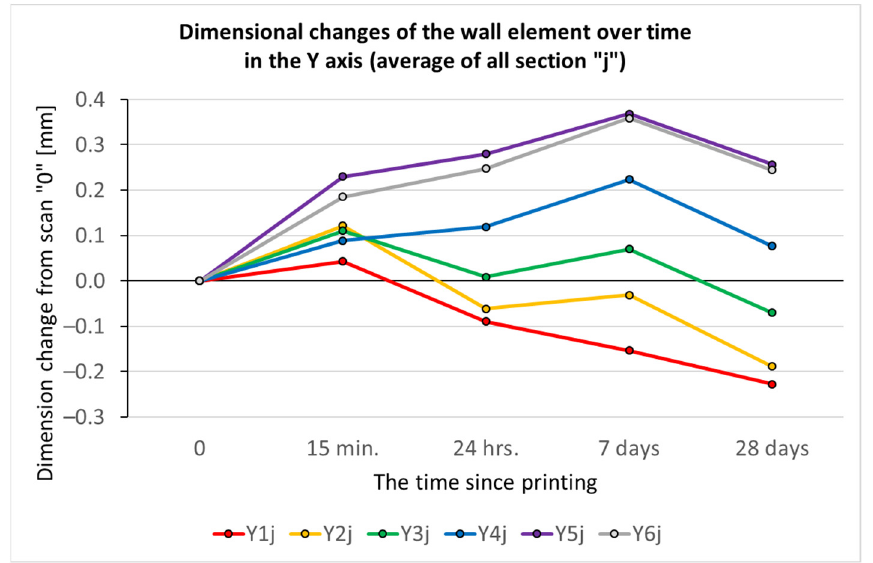
Figure 16. Dimensional changes of the wall element over time in the Y ‐ axis at each height level (based on local Caliper measurements).